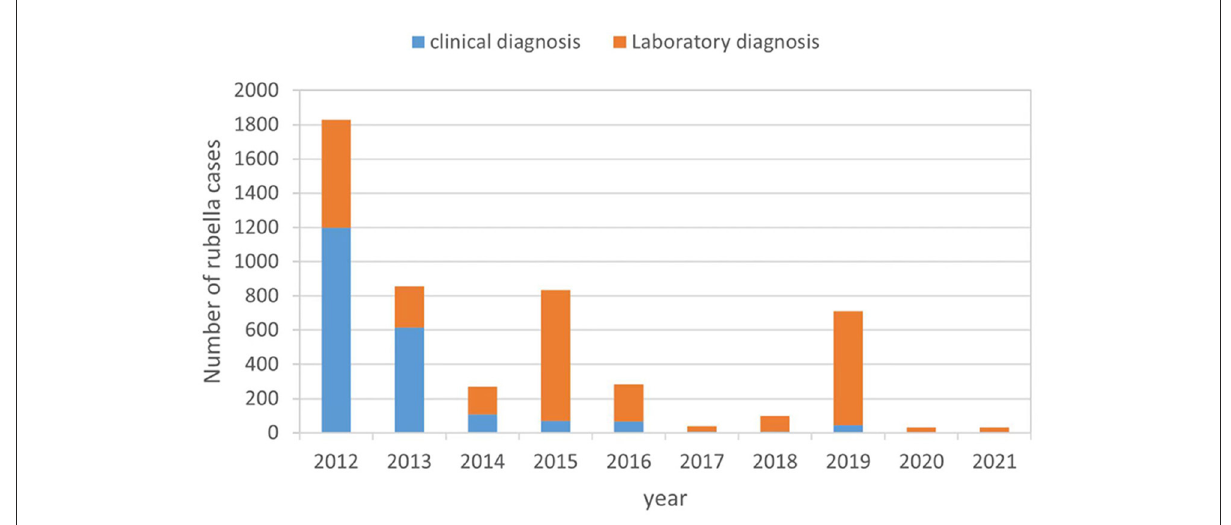
FIGURE2 Rubella surveillance performance in Anhui province from 2012 to